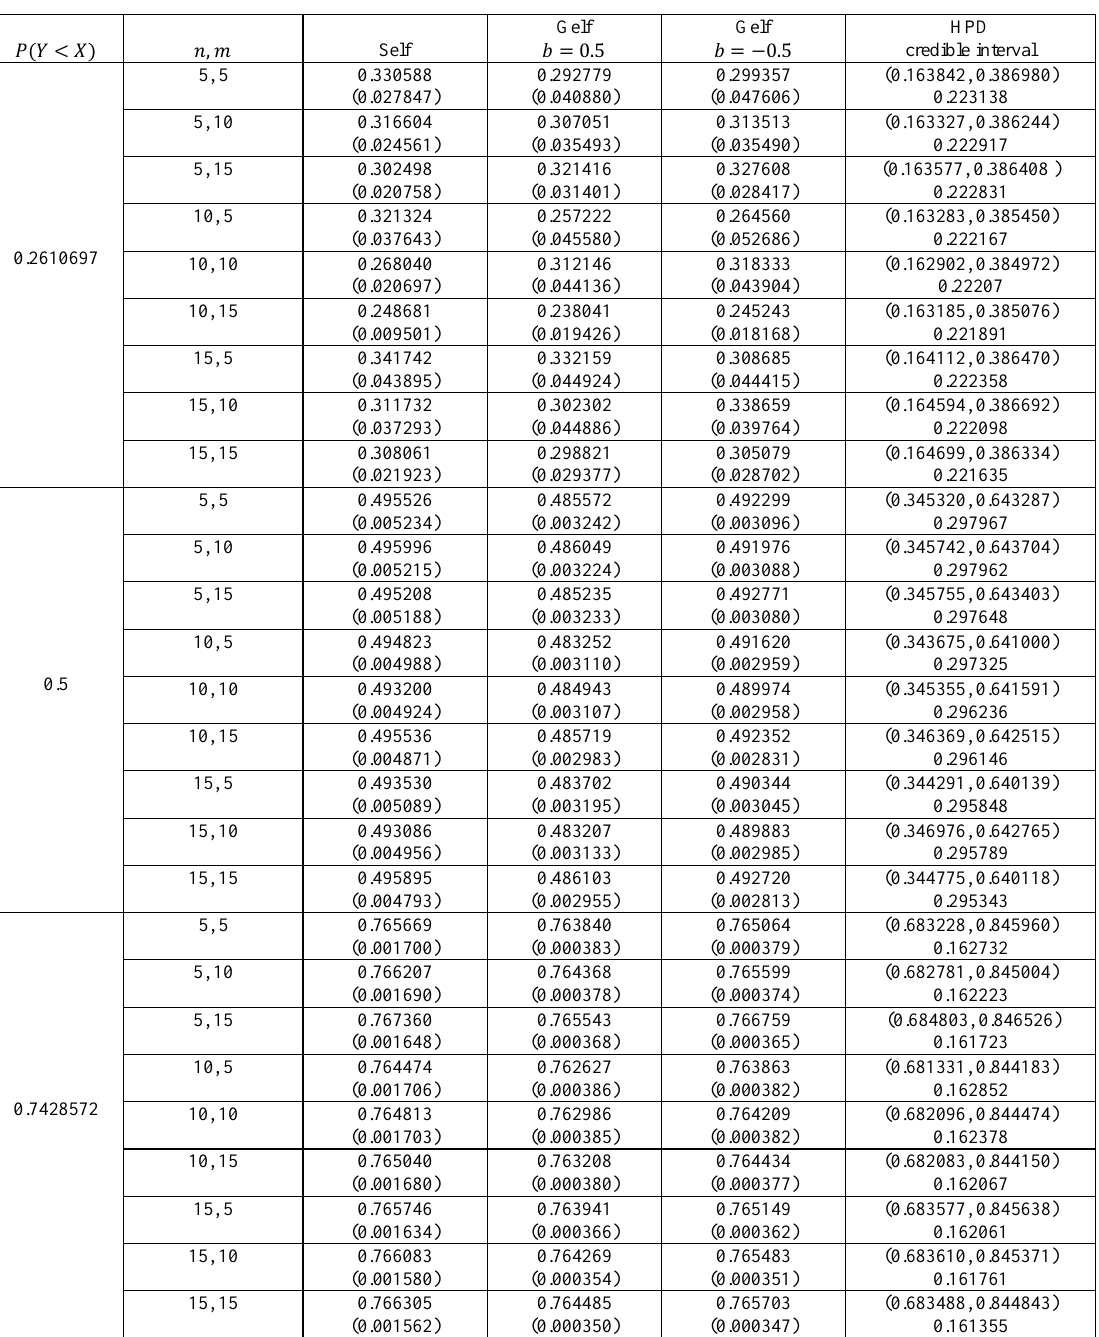
Table 2. Bayes estimates, expected loss functions (in brackets), HPD credible intervals (in brackets) with length for 𝜂 = 𝑃(𝑌 < 𝑋) using non-informative prior under squared error loss function (SELF) and Generalised entropy loss function